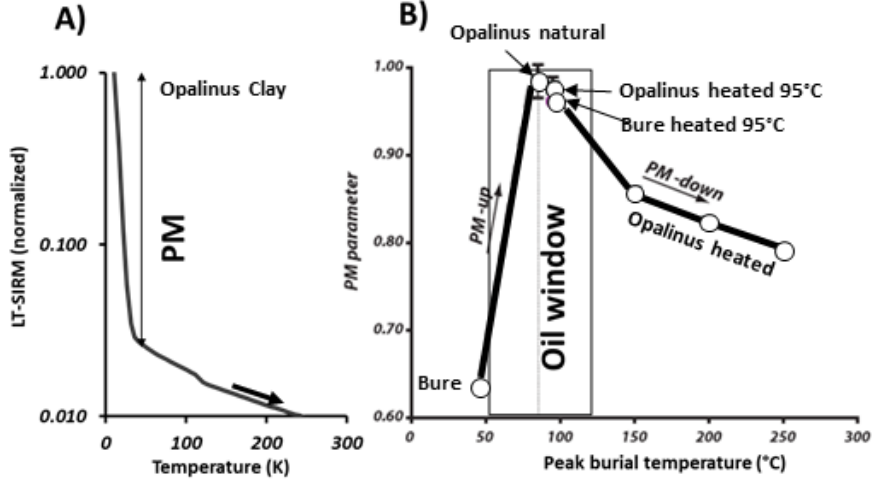
Figure 1. ( A ) Representative warming monitoring of artificial isothermal remanence imparted at 10 K at 2.5 Tesla (LT-SIRM) of Opalinus Clay from Mont Terri (Swiss). Note the log scale and the huge dropdown of LT-SIRM, quantified by the PM parameter. This indicated a large predominance of nanoparticles in the superparamagnetic state. ( B ) Published PM parameter versus peak burial temperature of natural shales (Opalinus and Bure) and laboratory-heated shales. The oil window is indicated. The maximum value of PM is localized in the oil window. Two branches, PM-up and PM-down, were drawn. This indicated that a PM value corresponded to two possible burial temperatures (redrawn from Aubourg and Pozzi [9].